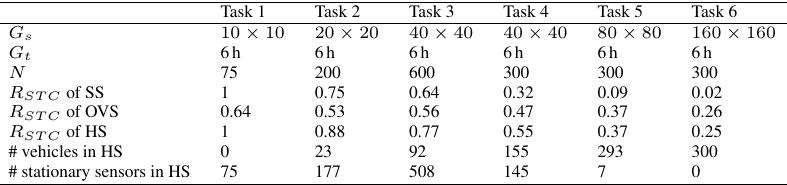
Figure 6(a)-(c) show R STC of SS, OVS and HS during the de- ployment (based on vehicle trajectories from 1-4 April 2018) and sensing task execution (based on vehicle trajectories from 5-7 April 2018). The green bars correspond to SS; the blue bars with and without grey lines correspond to OVS at deployment and at sensing task execution, respectively; the pure red bars correspond to HS at deployment, the red bars with grey lines and grey grids indicate HS-I and HS-II during task execution, respectively. Error bars on red bars with grey grid represent the standard deviation of R STC of HS-II. Overall, HS can obtain higher spatio-temporal coverage than OVS and SS, regardless of employing HS-I or HS-II, except for Task 5. More import- ories (during deployment), the predicted spatio-temporal cover- age is very close to the actual coverage obtained from